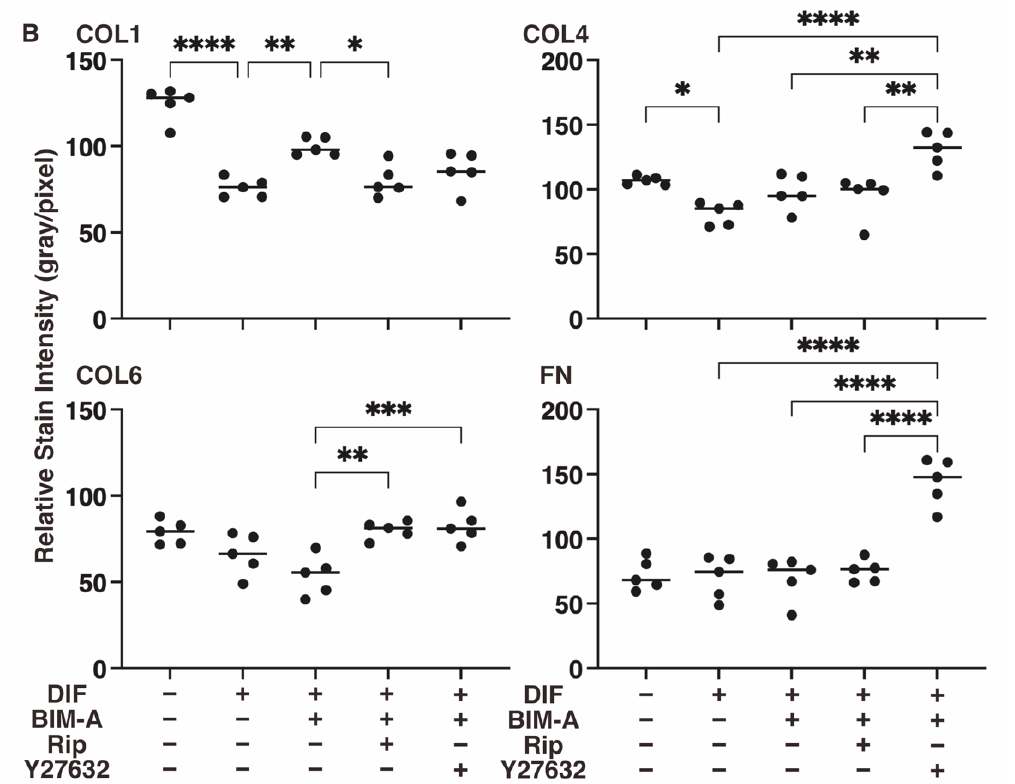
Figure 9. Representative confocal images showing the expression of ECMs in 3D 3T3-L1 spheroids under several sets of conditions. ( A ) On Day 7, the 3D cultures of spheroids of 3T3-L1 preadipocytes as the control (CONT), and their adipogenic differentiation in the absence (DIF) or presence of 100 nM bimatoprost free acid (BIM-A) and/or 10 μ M ROCK-i (Rip or Y27632), were immunostained with specific antibodies of ECMs designated by the green color. Scale bar: 100 μ m. ( B ) The staining intensities of the ECMs of the spheroids that were stained as above are plotted. All experiments were performed in duplicate using fresh preparations consisting of 5 spheroids each. Data are presented as the arithmetic mean ± the standard error of the mean (SEM). * p < 0.05, ** p < 0.01, *** p < 0.005, **** p < 0.001 (ANOVA followed by a Tukey’s multiple comparison test).